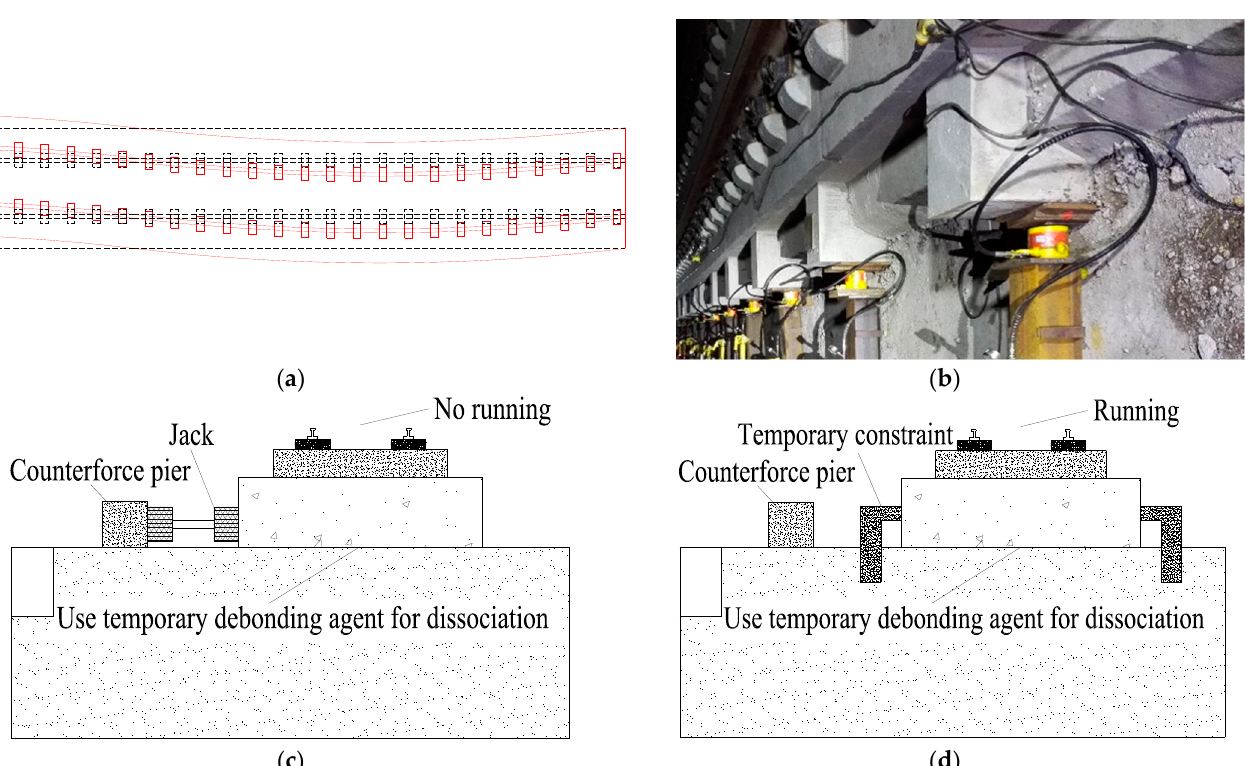
Figure 1. The overview diagram. ( a ) schematic diagram before and after the change in the route shape of the railway line; ( b ) an on-site view of the use of a jacking rectification fixing; ( c ) the cross section schematic diagram of the use of a jacking rectification fixing; ( d ) schematic diagram of the temporary constraint.